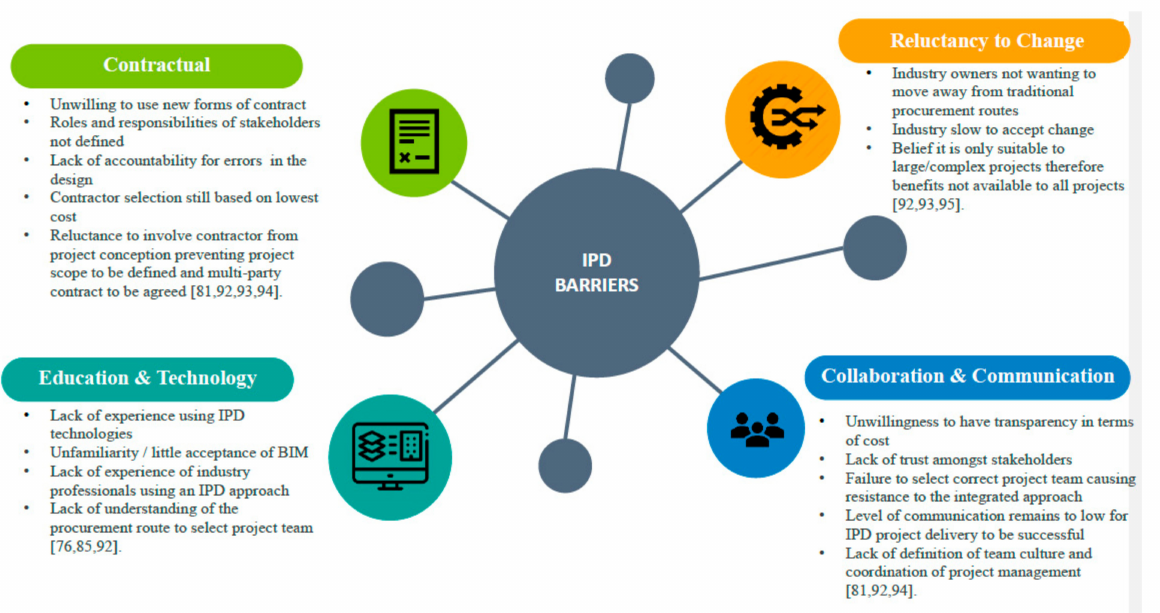
Figure 4. Barriers to integrated project delivery (IPD)